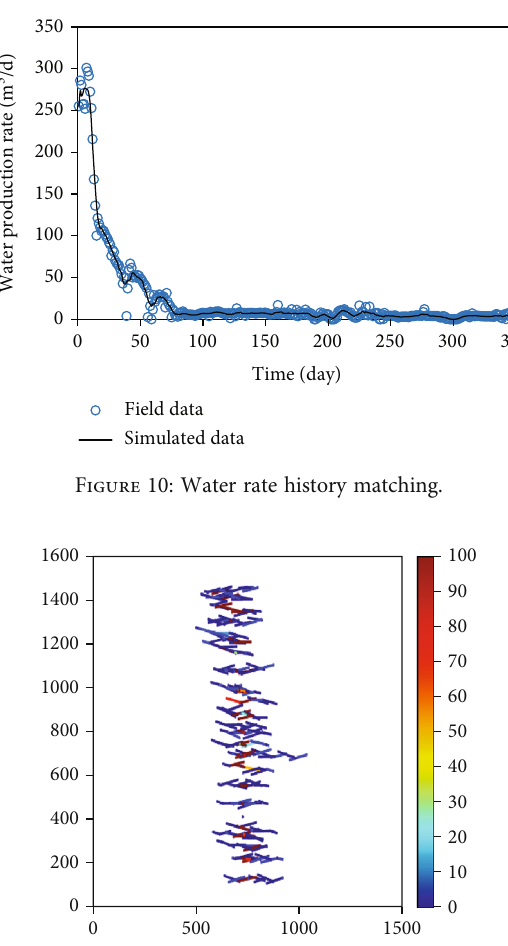
Figure 11: Historical fi tting results of conductivity.